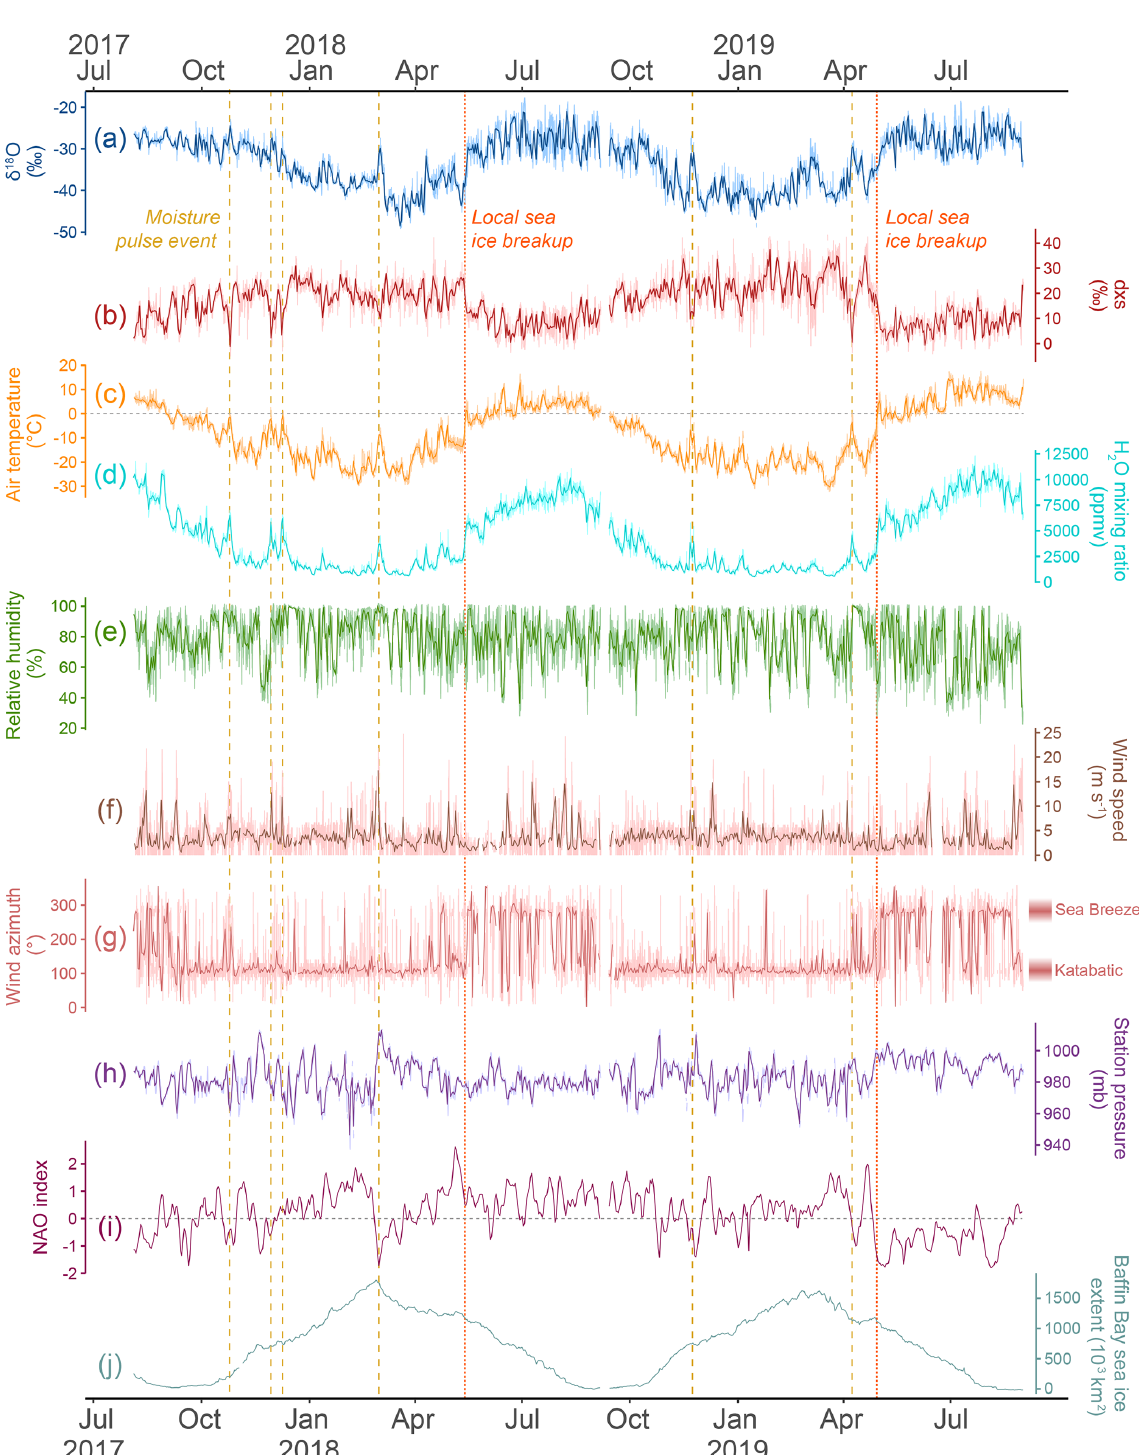
Figure 2. Observed data from Thule, Greenland, of (a) water vapor δ 18 O, (b) water vapor dxs, (c) mean air temperature, (d) water vapor mixing ratio, (e) relative humidity, (f) wind speed, (g) wind azimuth, (h) station pressure, (i) NAO index (NOAA, 2019), and (j) Baffin Bay sea ice extent (Fetterer et al., 2010). The time series of δ 2 H is very similar to δ 18 O and not shown. Data shown are daily mean values with hourly values as the lighter backdrop line for higher resolution variables (a–h) . All observations were taken at the SMT site, except for wind speed and azimuth which were observed at the Thule Airport (THU). Yellow dashed vertical lines indicate moisture pulse events, and orange dotted vertical lines indicate the timing of sea ice breakup near